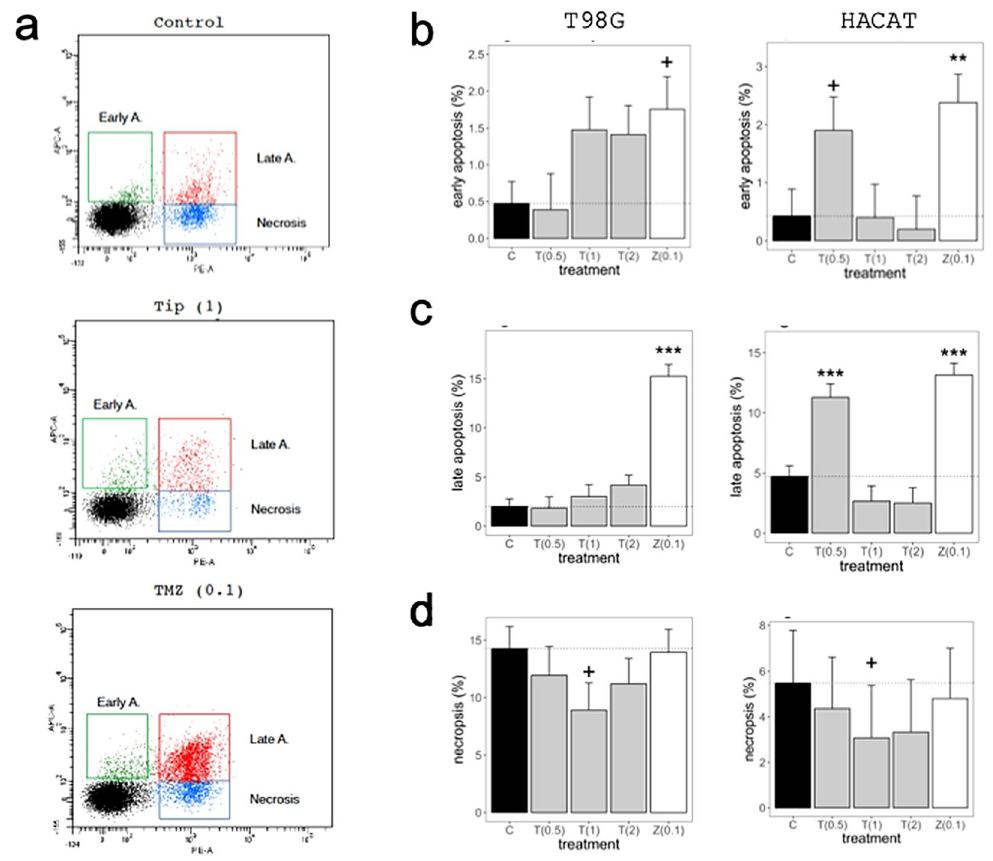
Figure 6. The effects of DAV in T98G and HACAT cell apoptosis were analyzed by flow cytometry at 72 h. ( a ) Early apoptotic (Annexin V-positive, PI-negative), late apoptotic (Annexin V-positive and PI-positive), and necrotic cells (Annexin V-negative and PI-positive) were included in cell death determinations by flow cytometry at 72 h. An example of T98G cells is shown. ( b ) Percentage of T98 early apoptotic cells (left) and HACAT early apoptotic cells (right) following treatment with concentrations of 0.5, 1, and 2 mg/mL DAV and with TMZ at 0.1 mg/mL. ( c , d ) The same analysis as ( a ) is shown for late apoptotic cells and necrotic cells, respectively. Values in brackets stand for compound concentration in mg/mL. Linear mixed models to assess the effects of treatments were used as described in Fig. 1. Data are means ± SEM (n =